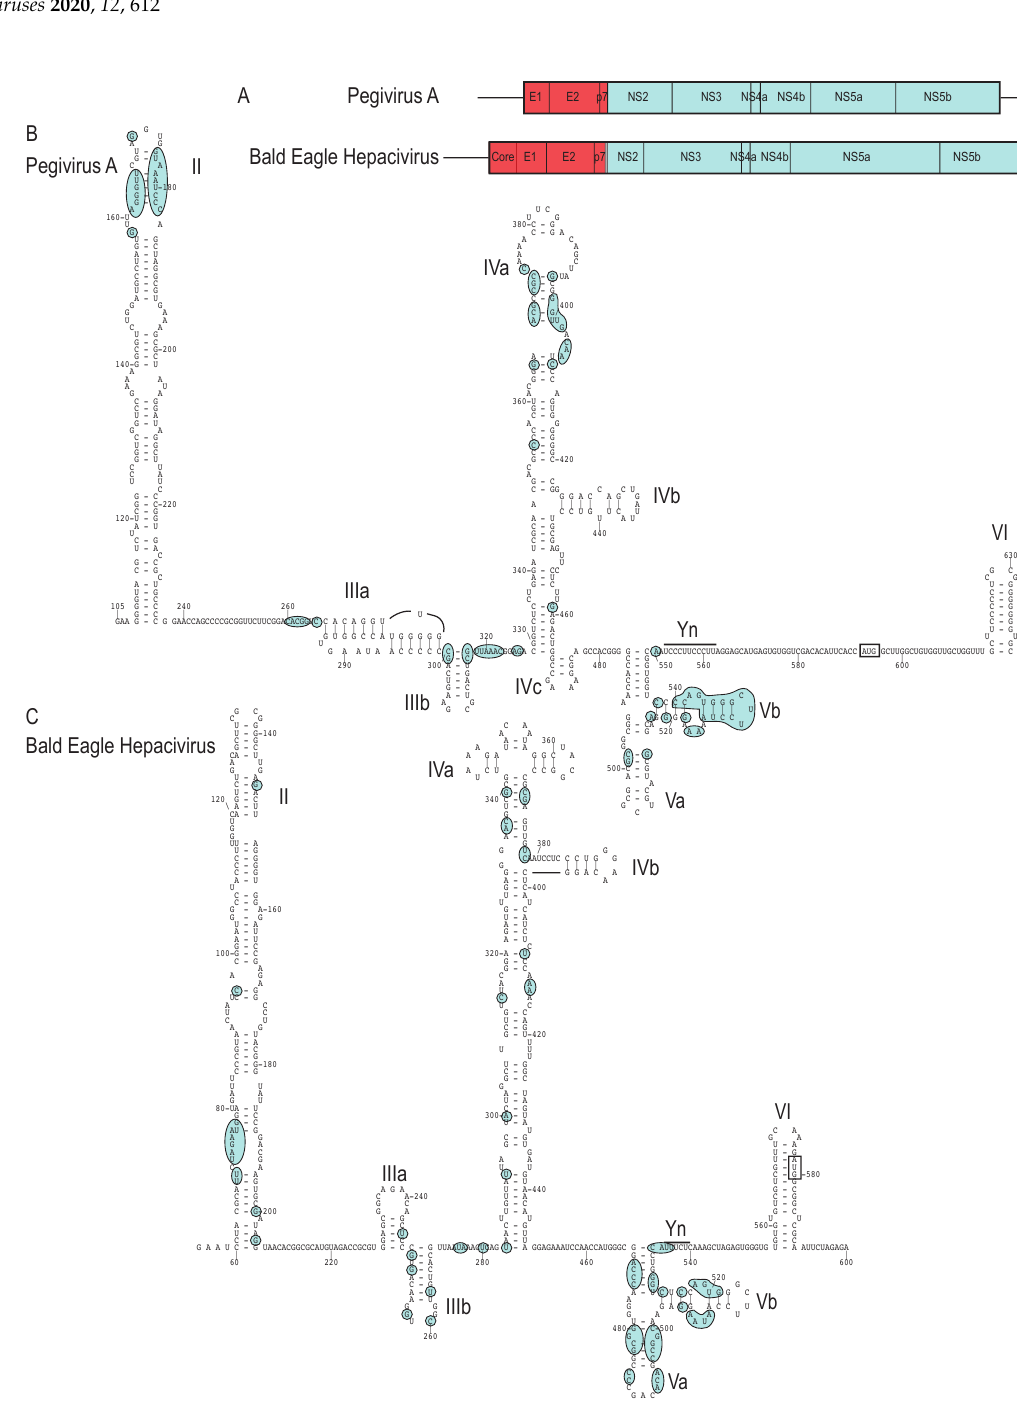
Figure 6. Structurally related IRESs in Pegivirus A and Bald eagle hepacivirus ( A ) Schematic representations of pegivirus A and Bald eagle hepacivirus (BeHCV), showing the ORFs encoding the polyprotein in each, the individual proteins that are cleaved from each by cellular and viral proteins, the flanking noncoding regions flanking the ORFs. Note that the IRESs are located adjacent to unrelated coding sequences, namely the pegivirus E1 envelope glycoprotein and the BeHCV Core protein, respectively. ( B ) Secondary structure model of a segment of the 5 (cid:48) UTR of pegivirus A [83] (NCBI ref. seq. NC_001837.1) and ( C ) secondary structure model of a segment of the 5 (cid:48) UTR of BeHCV (GenBank: MN062427). A similar model to that shown for BeHCV has been proposed for the 5 (cid:48) UTR of Duck hepacivirus [160]. Domains are labeled II – VI, and nucleotides are numbered at 20 nt. intervals. The initiation codon is boxed and the pyrimidine tract is labeled Yn. The shaded elements